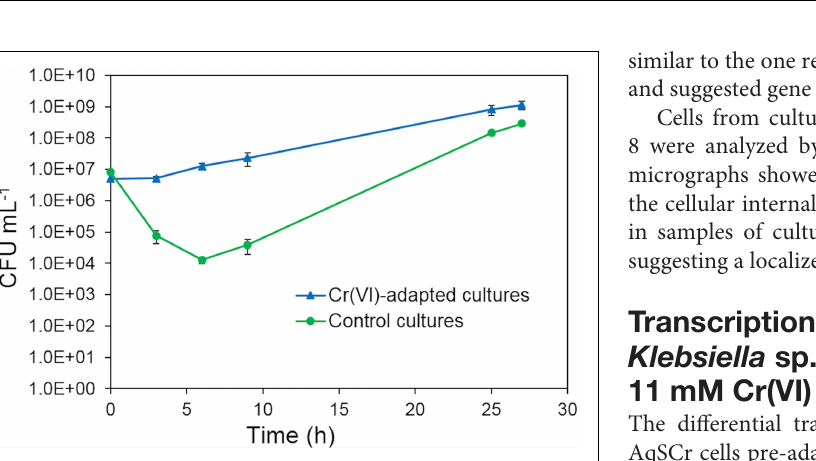
FIGURE 2 | Cr(VI) reduction by Klebsiella sp. strain AqSCr. (A) Anaerobic chromate reduction in sodium citrate medium. (B) Aerobic chromate reduction in unbuffered LB medium, phosphate-buffered LB medium, and HEPES-buffered LB medium. (C) In vitro chromate reductase activity in soluble and membrane fractions of Klebsiella sp. strain AqSCr with and without NADH.